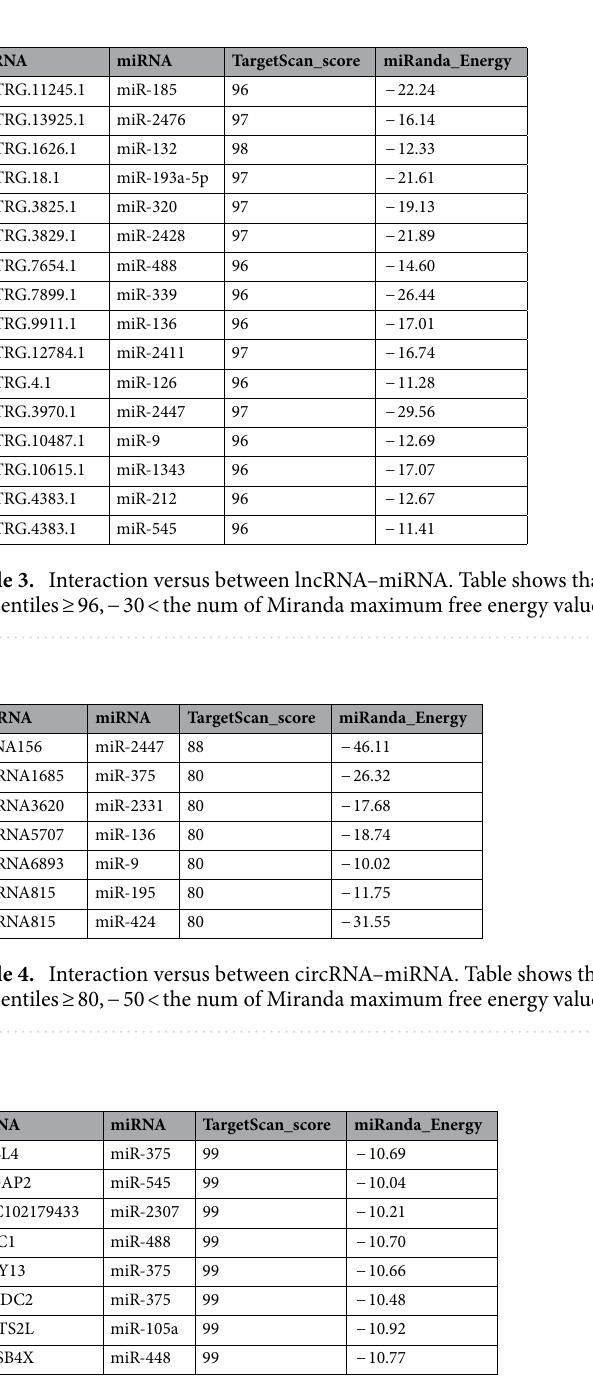
Table 5. Interaction versus between miRNA–mRNA. Table shows that the num of TargetScan fractional percentiles ≥ 99, − 11 < the num of Miranda maximum free energy values < −